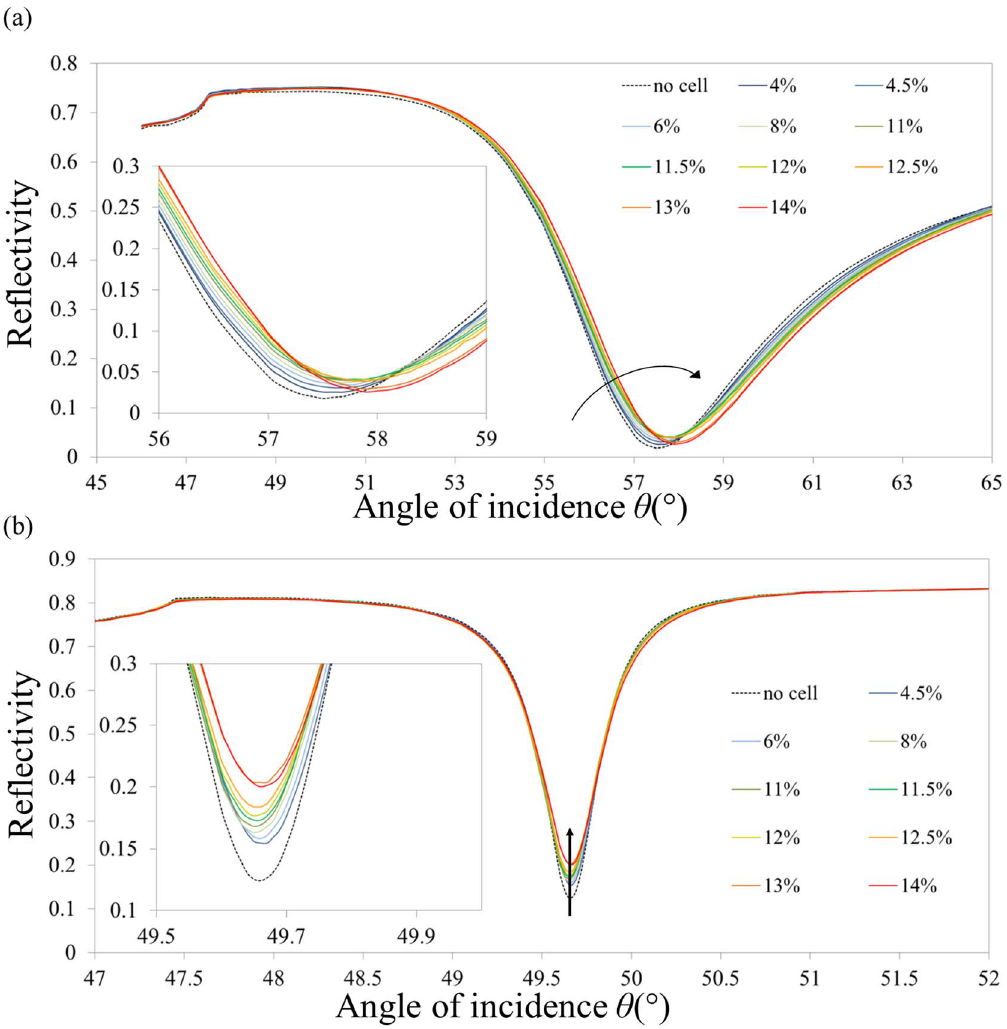
Figure 4. Typical reflectivity spectra of cSPR and LRSPR upon cellular spreading. (a) cSPR spectra and (b) LRSPR spectra. The cell seeding density was of 150 cells/mm 2 . The arrows show the evolution of the spectra. The insets show a close-up of the minimum of intensity. The coverage values were inferred from the curve in Figure S2.